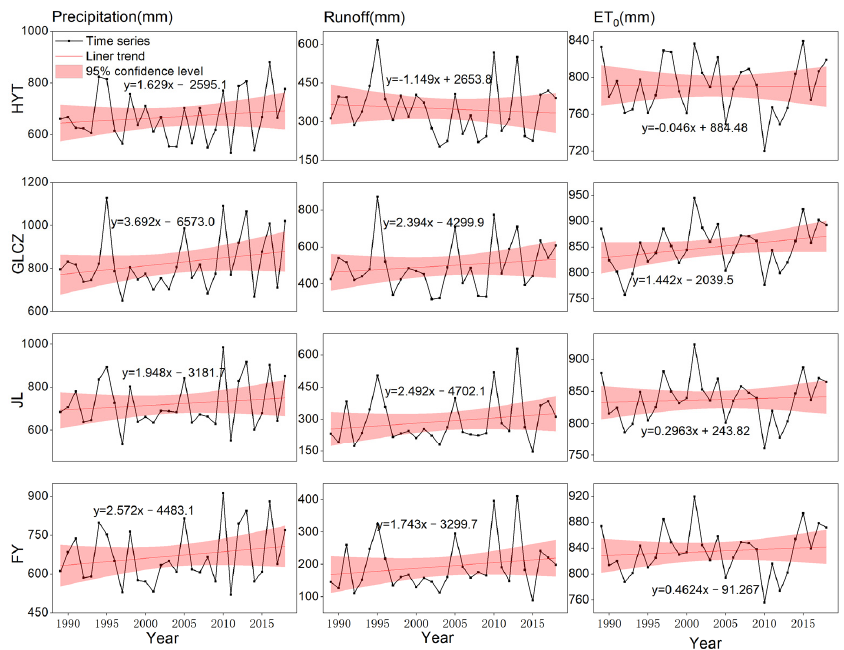
Figure 2. Trends in precipitation, runoff, and potential evapotranspiration of sub-basins controlled by HYT, GLCZ, JL, and FY stations from 1989 to 2018.